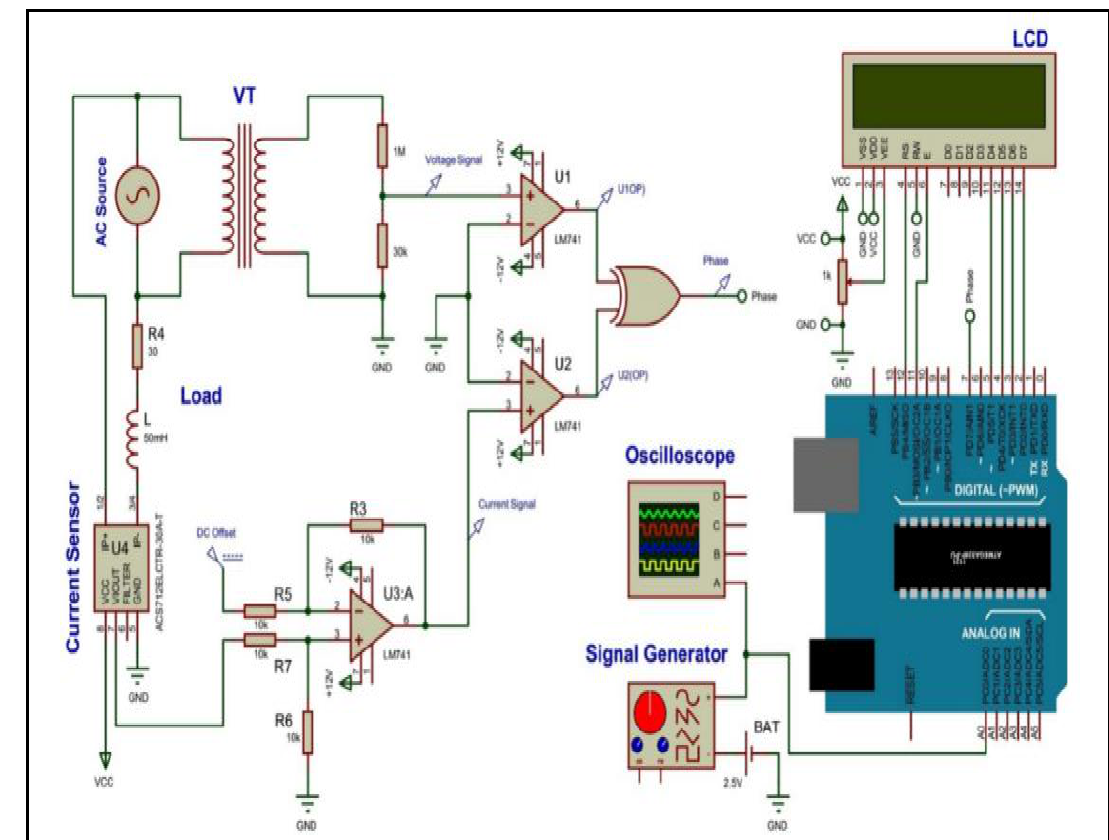
Electronics 2022 , 11 , x FOR PEER REVIEW Figure 9. Overall design of SAPF using Proteus VMS. Figure 9. Overall design of SAPF using Proteus VMS.